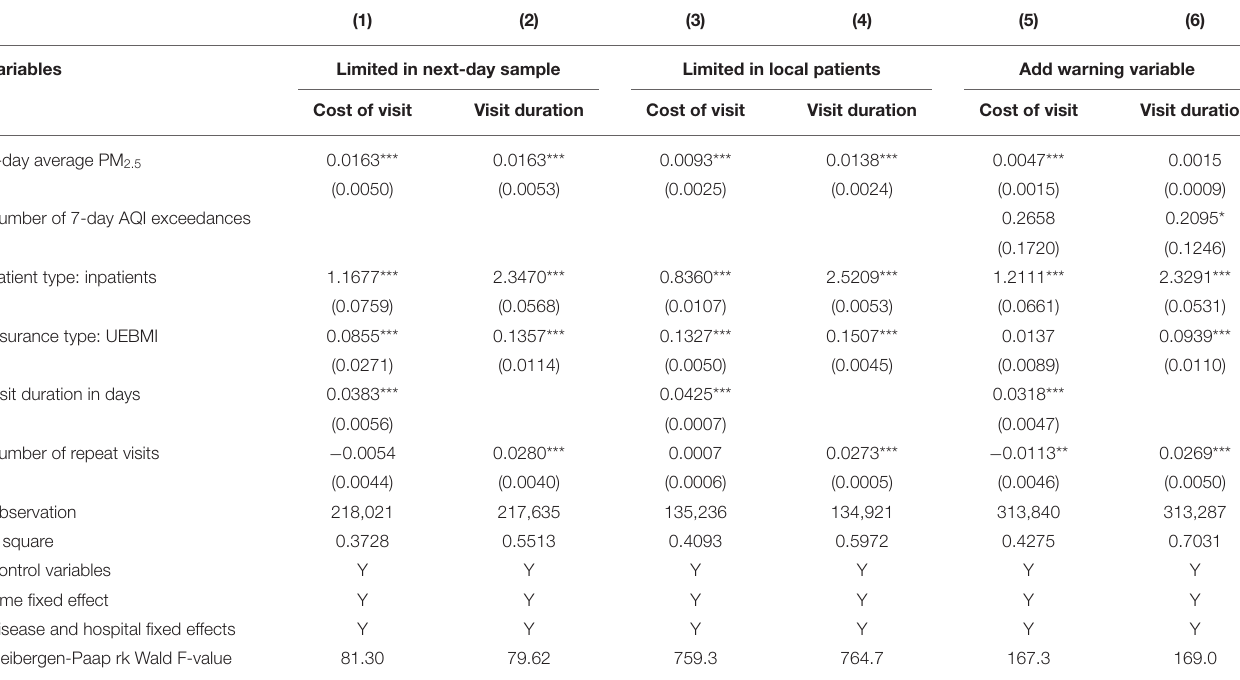
TABLE 5 | Robustness